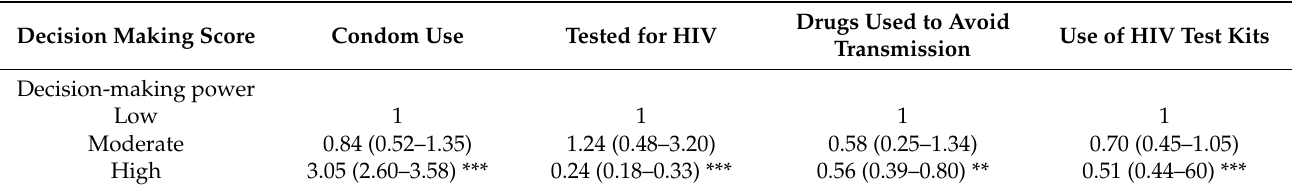
Table 2. Relationship between decision-making power and HIV prevention behavior among women of South Africa.